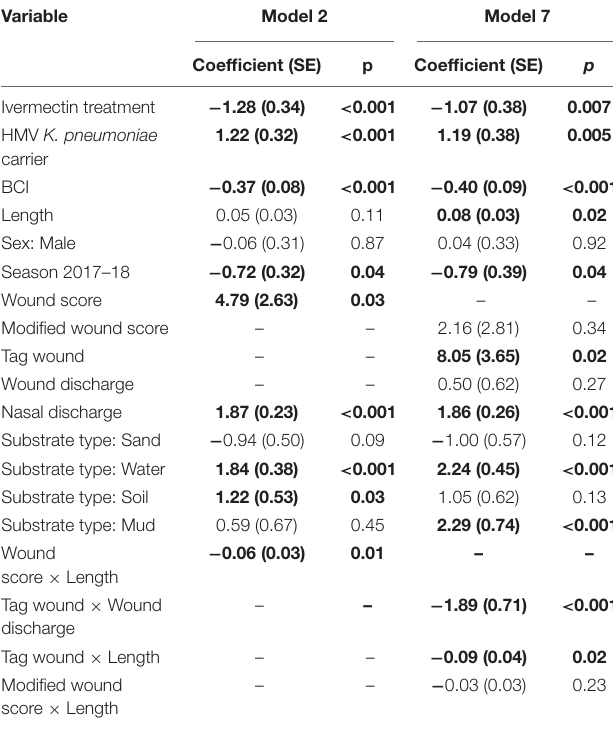
TABLE 4 | Summary results of Cox proportional hazards models 2 and 7, analyzing risk factors for hypervirulent Klebsiella pneumoniae mortality in New Zealand sea lion ( Phocarctos hookeri ) pups at Sandy Bay, Enderby